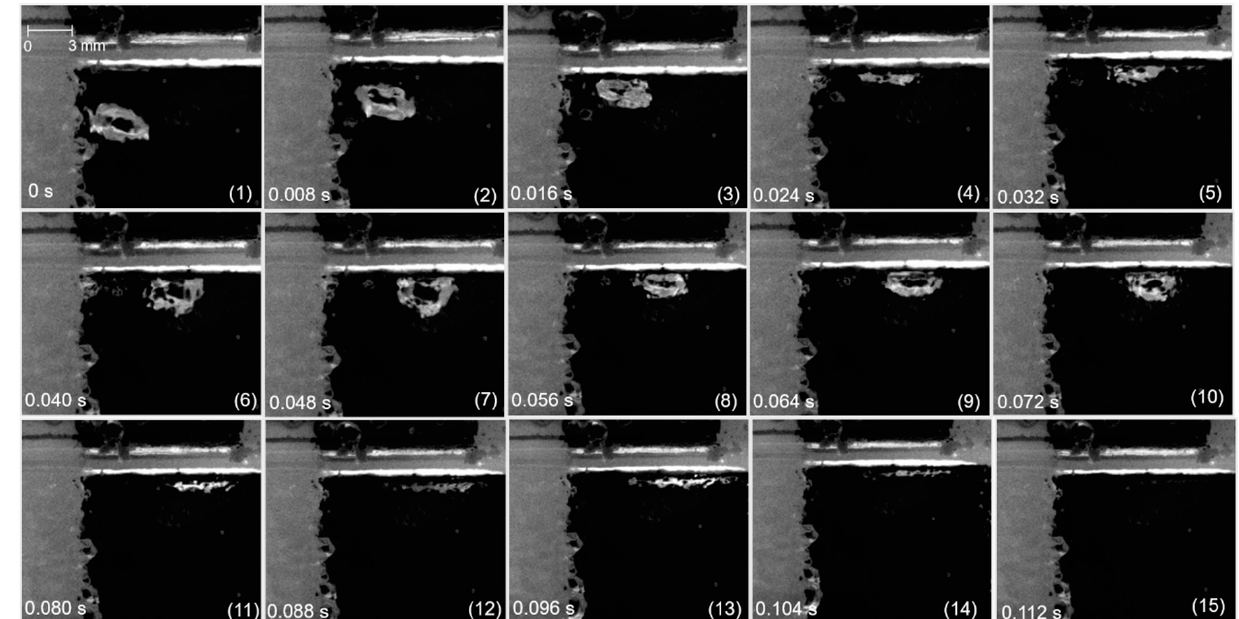
Figure 15. Bubble bouncing and bursting at the bath surface after detachment from the vertical anode at 0.1 A cm − 2 . Upper BN part of the anode is shown. The frame number is given in the brackets. Frame (1) is defined as 0 s, indicating bubble detachment from the carbon surface and rise. A scale bar is shown in frame (1).